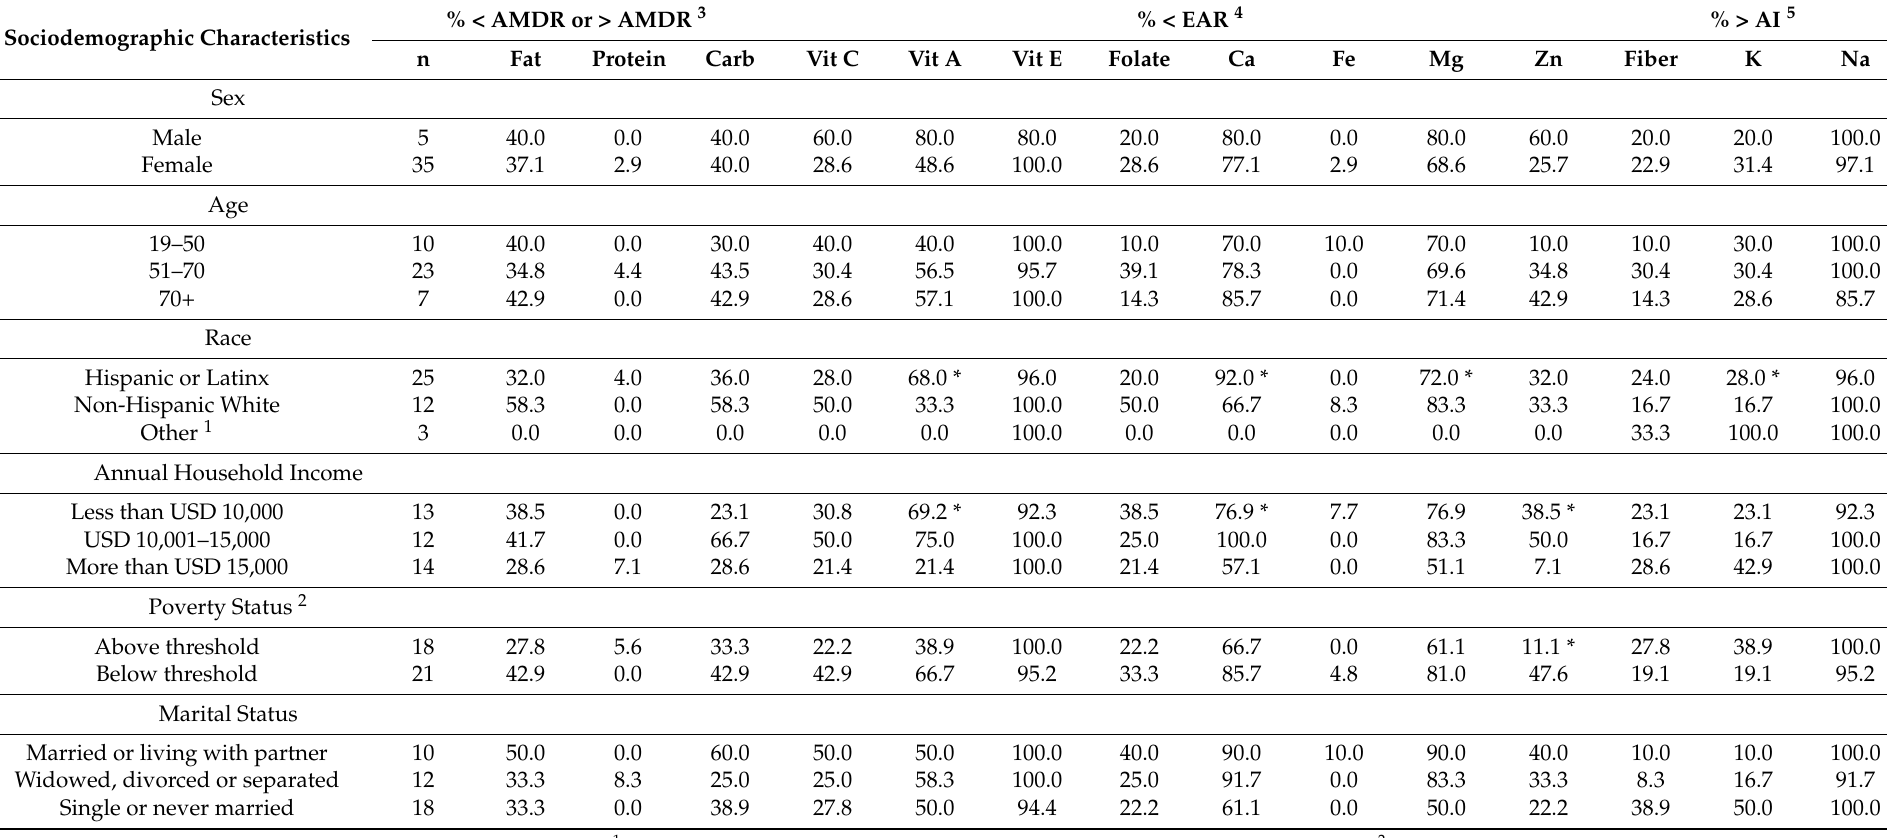
Table 5. Nutrient inadequacy based on 3-day dietary records of mobile food pantry users by sociodemographic factors ( n = 40). Sociodemographic